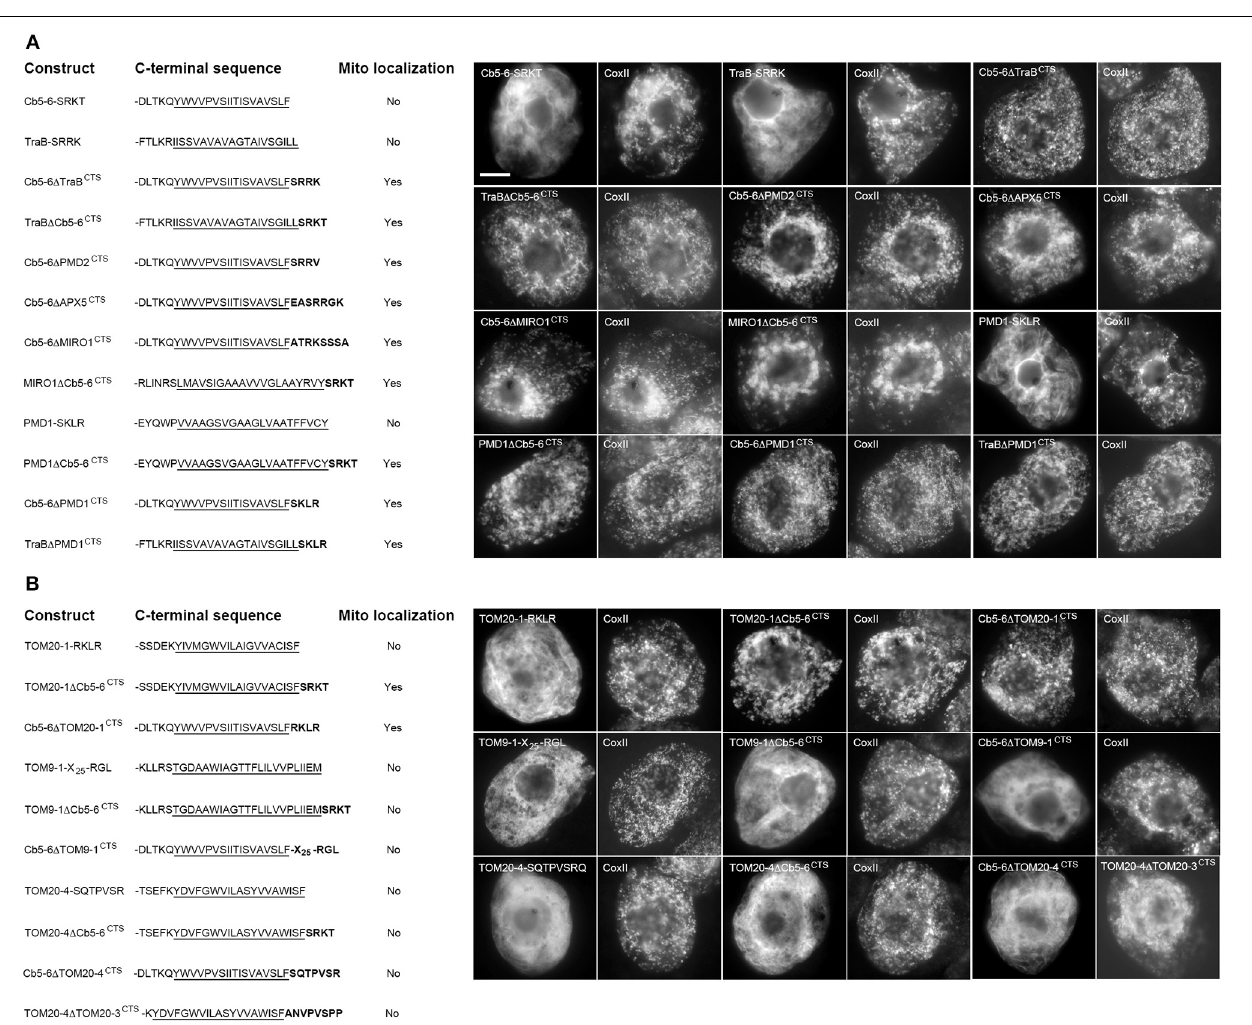
each construct is the corresponding C-terminal amino acid sequence, including putative TMD (underlined) and modified CTS (bolded), or lack thereof. Mitochondrial localization (indicated as “Yes” or “No”) was assessed based on colocalization (or lack thereof) of the expressed protein and the endogenous mitochondrial CoxII. Shown on the right in both (A) and (B) are representative immuno-epifluorescence micrographs illustrating the localization of the various constructs shown on the left. Each micrograph is labeled with the name of either the expressed Myc-tagged CTS mutant or hybrid protein or endogenous CoxII. Bar in (A) = 10 μ